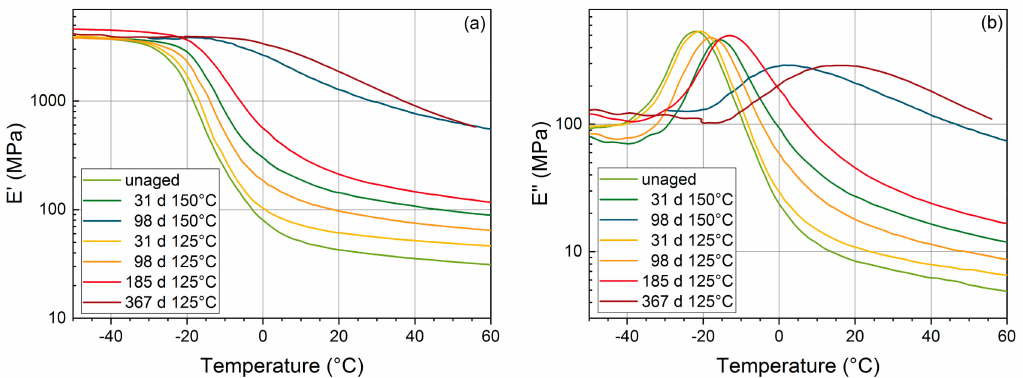
Figure 3. Storage modulus E (cid:48) ( a ) and loss modulus E” ( b ) of hydrogenated nitrile butadiene rubber (HNBR) vs. temperature measured on sheet material at 1 Hz measurement